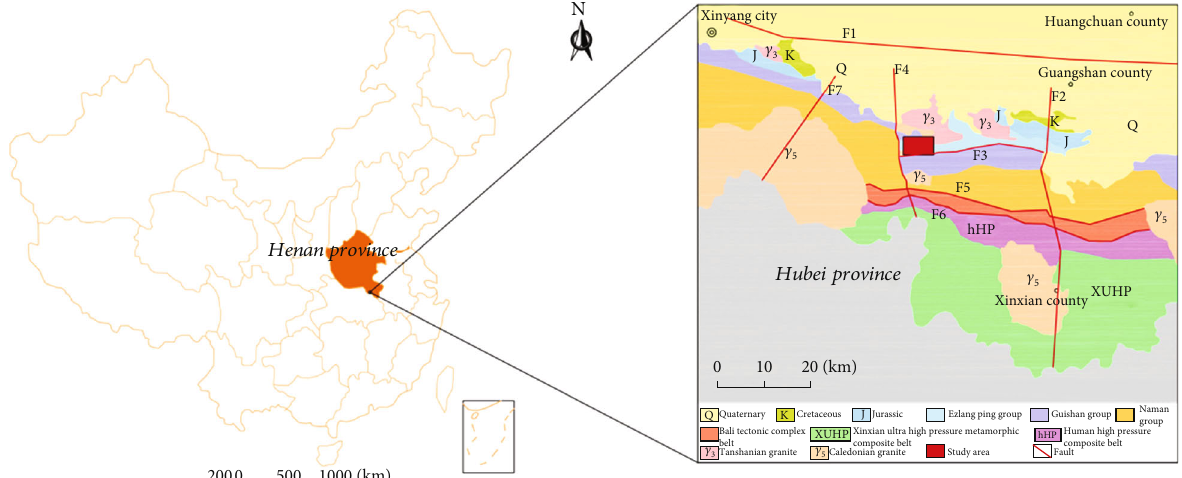
Figure 1: The study area location.